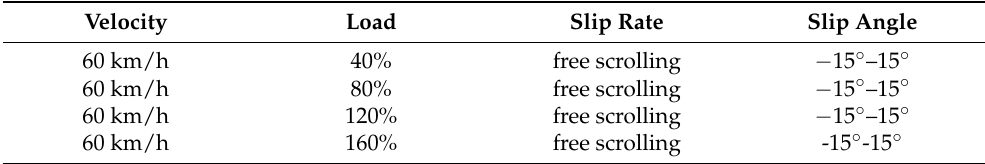
Table 3. Tire force pure cornering test conditions.